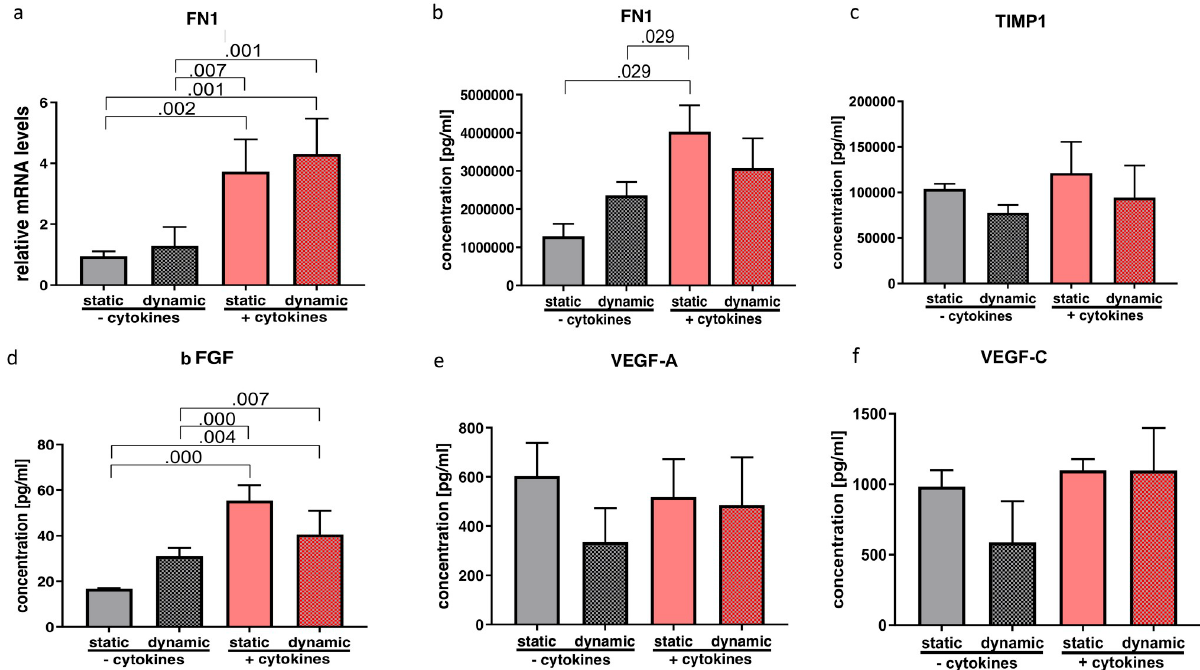
Fig 5. Effect of cytokine treatment and/or vibration on ECM-related molecules, growth factors and angiogenic factors. mRNA (a) and protein levels (b-d) of ECM-related molecules as well as growth- and angiogenic factors were analyzed by RT-qPCR and Luminex, respectively. Results are represented as mean ± S.D. of four independent experiments (N = 4). Statistical analysis was performed using one-way ANOVA (normally distributed data) or Kruskal-Wallis test (non-parametric data), p < 0.05 was considered significant; decimal numbers above the bars represent the statistically significant p-values from post-hoc comparisons. For the p-values not presented here, see S2 File. FN1 (fibronectin 1), TIMP1 (Tissue inhibitor of metalloproteinase), bFGF (basic fibroblast growth factor), VEGF A (vascular endothelial growth factor A), VEGF C (vascular endothelial growth factor